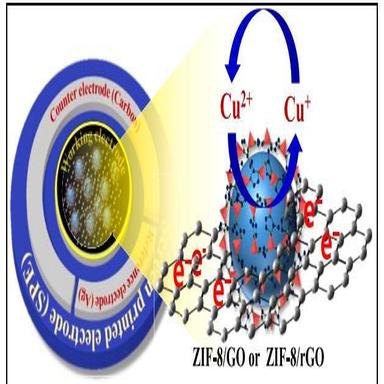
Proposed Cu2+ ion sensing mechanism for SPE based on ZIF-8/GO and ZIF-8/rGO composites.